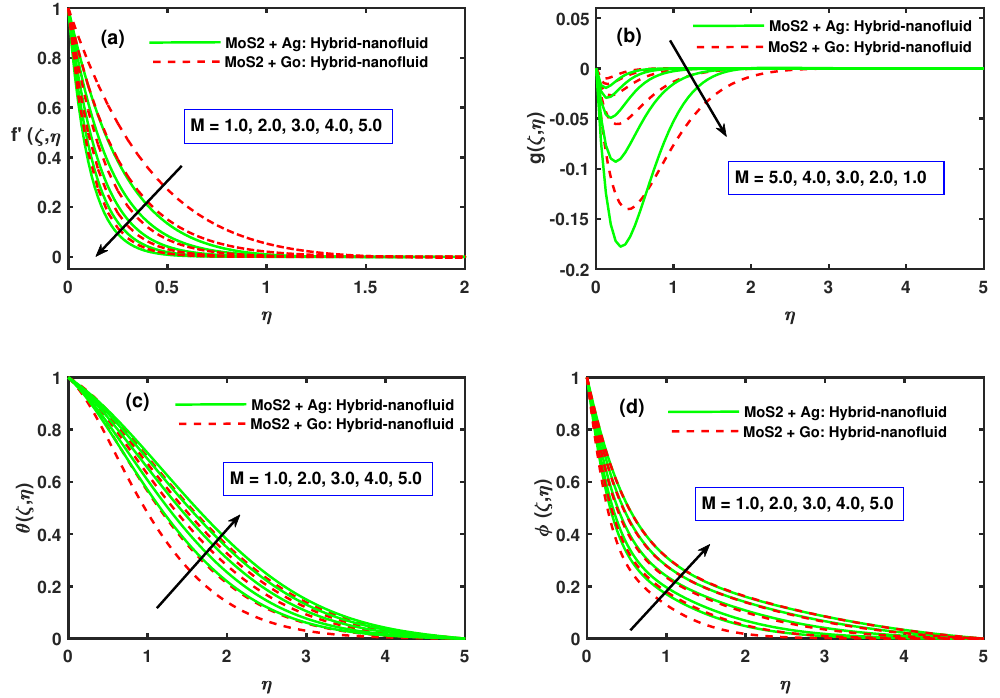
Figure 3. Fluctuation of f (cid:48) ( ζ , η ) , g ( ζ , η ) , θ ( ζ , η ) , and φ ( ζ , η ) along with M (magnetic field) at ζ =